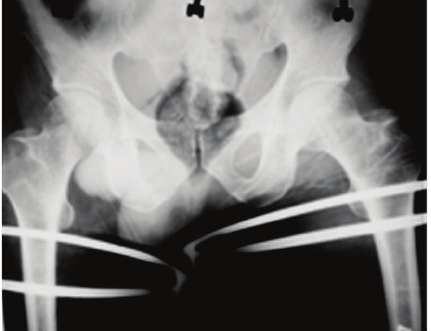
Figure 1: Clinical picture of the patient lying on the operation table showing the attitude of the lower limbs.